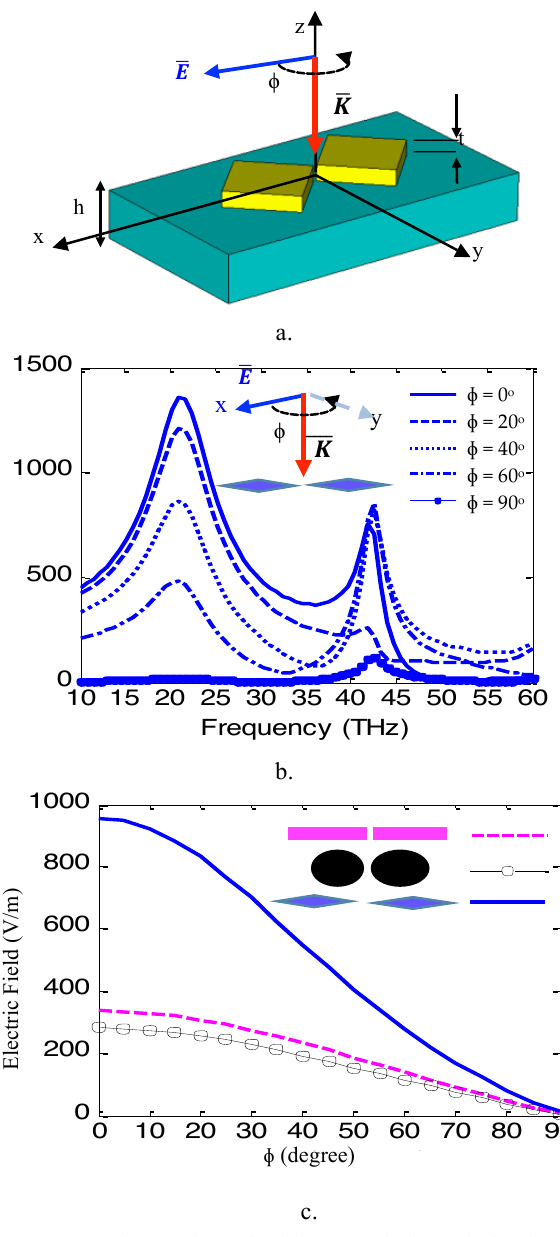
Figure 10a. The angle of incidence and the polarization of the incident electromagnetic field directly affect the voltage induced on the nanoantenna device, b. The electric field variation versus ɸ for different shapes of the dipole IR - nanoantenna on a die lectric substrate at 28.3 THz, c. The electric field variation versus frequency for rhombic dipole IR - nanoantenna on a dielectric substrate with h=150 nm, w=5 µ m, L=5 µ m, t=50 nm, gap=10 nm, L and different values ɸ .